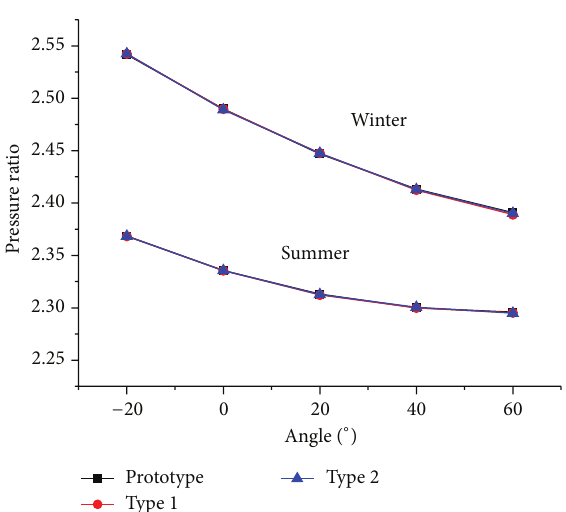
Figure 8: The change of pressure ratio with the setting angles.